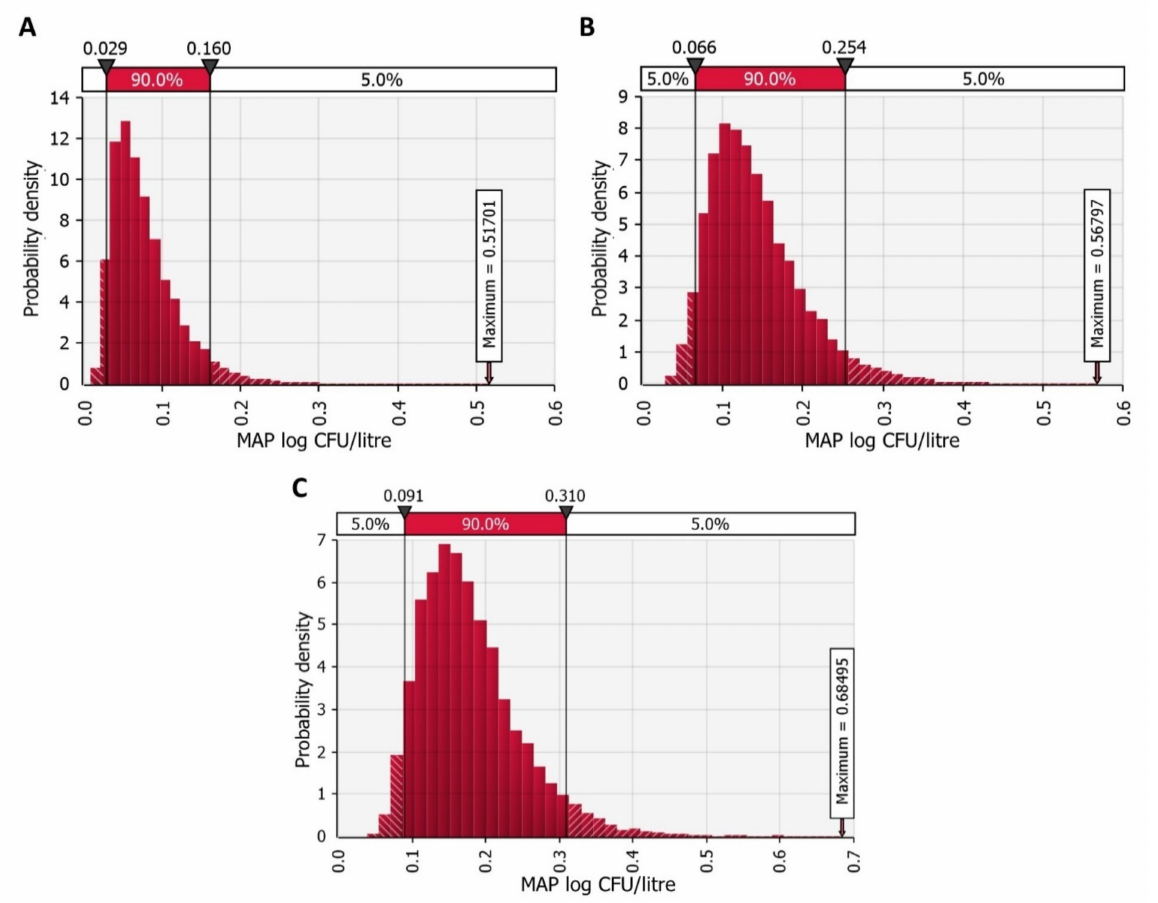
Figure 4. Mycobacterium avium subsp. paratuberculosis (MAP) contamination of pasteurised milk at the dairy industry level using three scenarios of mean paratuberculosis prevalence: ( A ) scenario 1 with 21.3% prevalence, ( B ) scenario 2 with 38.89% prevalence, and ( C ) scenario 3 with 49.21%